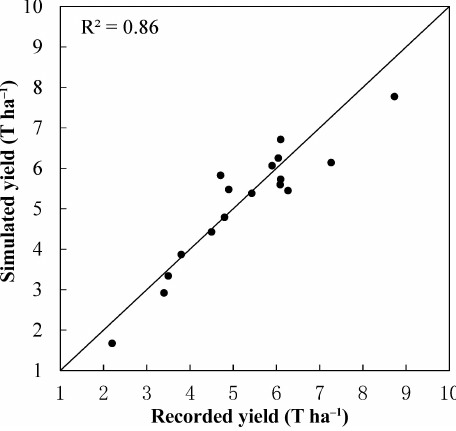
Figure 4. Validation of the genetic parameters using the recorded yields of spring maize at six stations in the study area from 2000 to